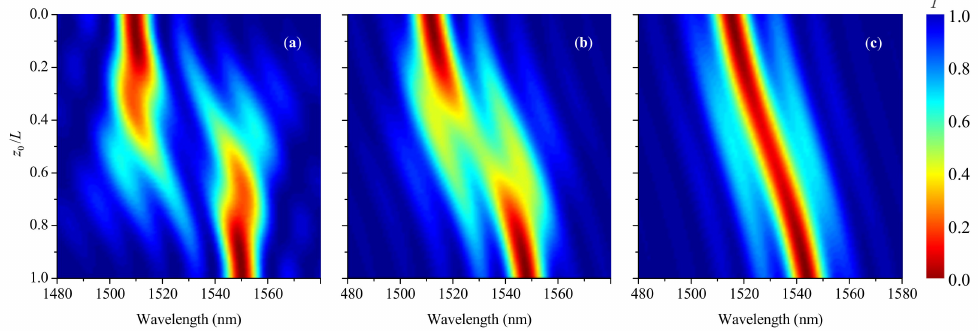
Figure 5. Evolution of transmission spectra with transition point z 0 moving through the grating for three magnitudes of smoothness η : ( a ) 0, ( b ) 10 mm, and ( c ) 20 mm ( s 0 = 18